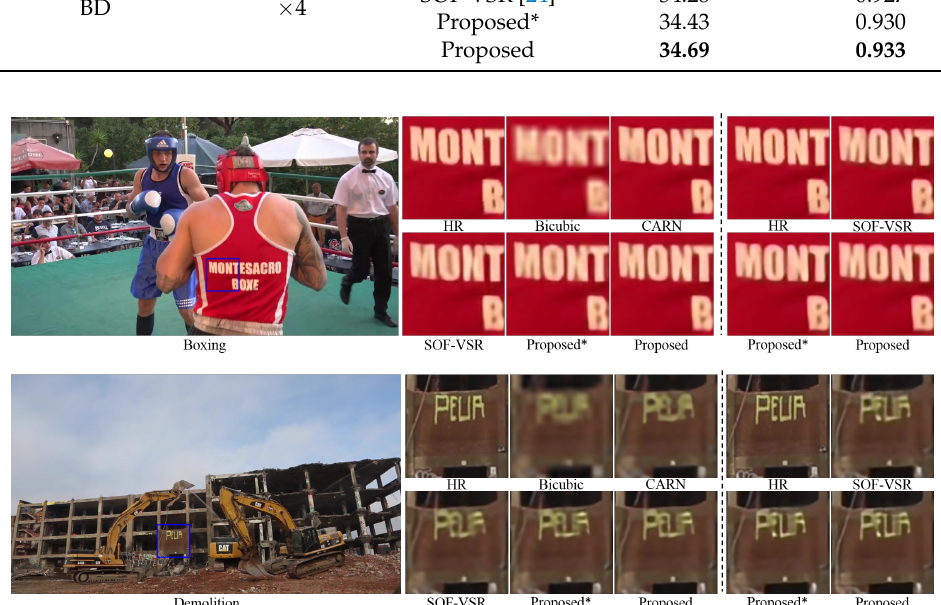
Figure 8. Visual comparisons of reconstruction results of × 4 scale on boxing and demolition video frames. The left side of the dashed line is the reconstruction result of the BI degradation model. The magnified area is the HR in sequence, and the reconstruction results of methods Bicubic, CARN, SOF-VSR, Proposed*, Proposed. The right side of the dashed line is the reconstruction result of the BD degradation model, and the zoomed-in area is HR, the reconstruction results of methods SOF-VSR, Proposed* and Proposed based on BD degradation model. The method marked with * only used non-local